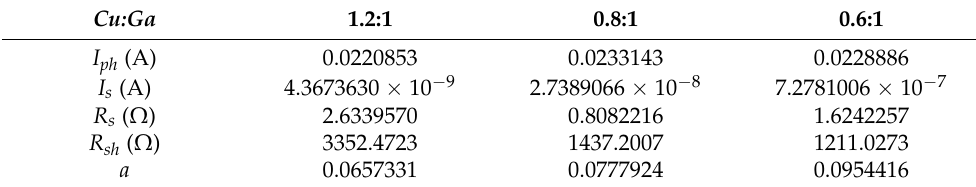
Figure 6. Absolute errors of I-V characteristics between symbols and lines in Figure 4. Table 3. Parameter estimation values for I- and P-V characteristics in Figures 4 and 5.